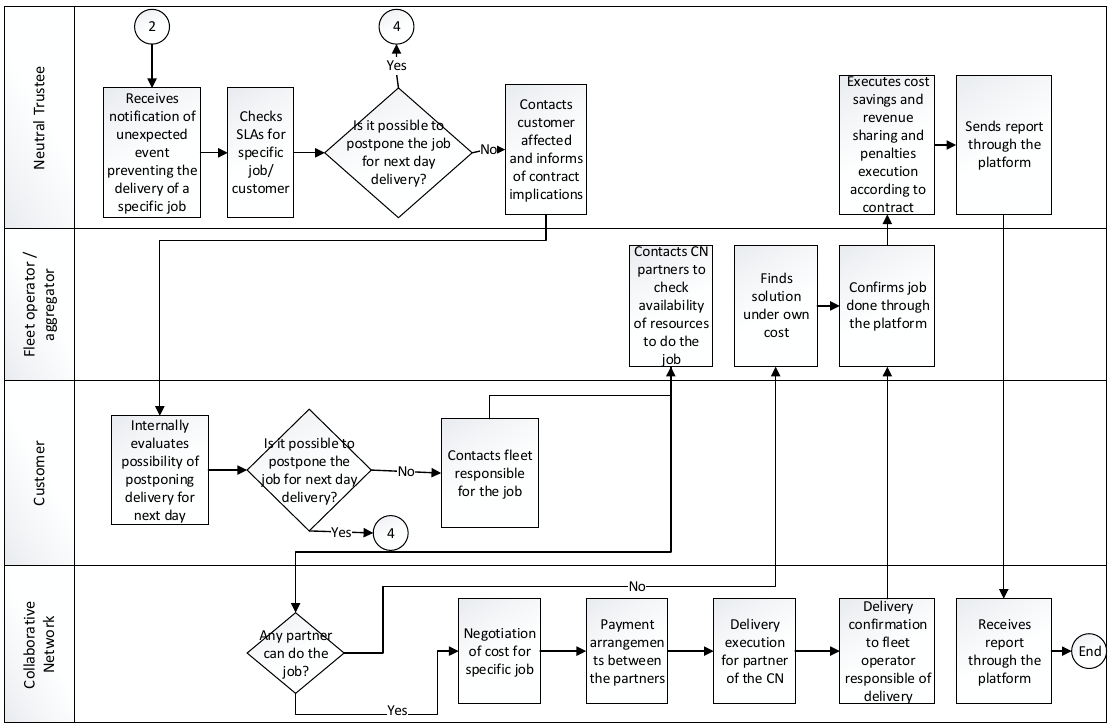
Figure 12. Workflow for proposed FSL business model—Collaboration operation.